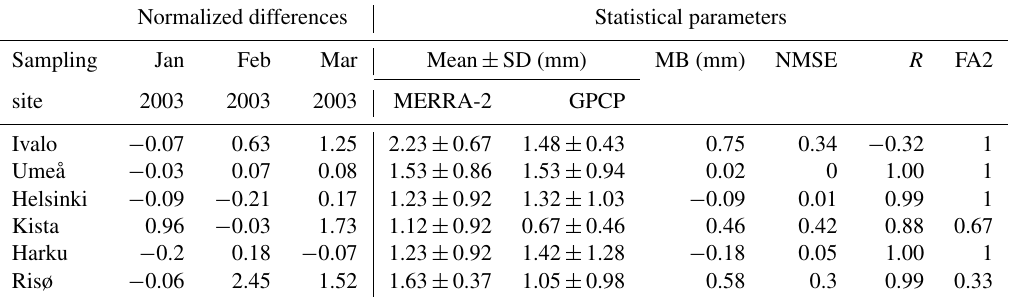
Table 1. Normalized differences between the MERRA-2 and observed precipitation, calculated as differences between the MERRA-2 and the observed values, normalized over the observed value, at each sampling site (left). Positive values indicate that the model tends to over- estimate observations while the negative ones indicate underestimation. Statistical parameters (mean ± SD = mean ± standard deviation; MB = mean bias; NMSE = normalized mean square error; R = correlation coefficient; FA2 = factor of 2) indicating the model performance in reproducing GPCP monthly accumulated precipitation at the six sampling sites in northern Europe (right).